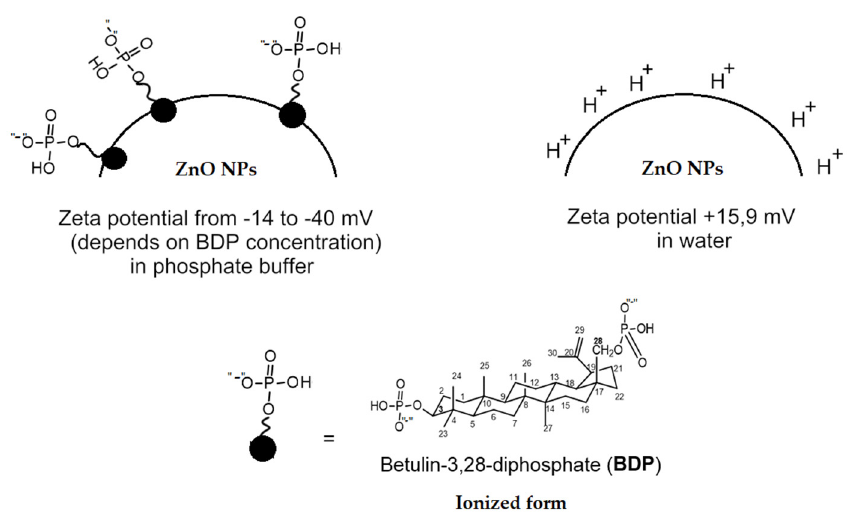
Figure 4. Schematic illustration of BDP ionization in phosphate-buffered saline, BDP immobilized into ZnO NPs and ZnO NPs in water.